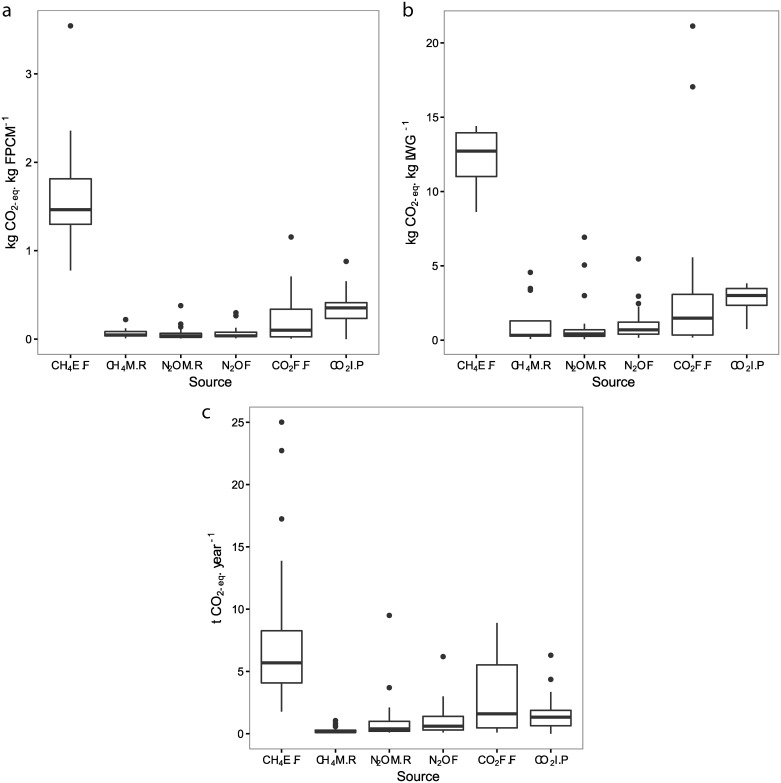
Mean GHG emissions (n = 30) from different sources in relation to a. milk produced; b. liveweight gain; or c. per year.The emission sources are methane from enteric fermentation (CH4E.F), methane from manure residues (CH4M.R), nitrous oxide from manure residues (N2OM.R), nitrous oxide from fertilizer use (N2OF), carbon dioxide from fossil fuel (CO2F.F) and carbon dioxide from producing inputs (CO2I.P). Emissions are expressed in a. kg CO2-eq. (kg FPCM†)-1
b. kg CO2-eq. (kg LWG)-1, live weight gained animal-1 day-1
c. tonnes CO2-eq. per farm year-1. Circles indicate outliers. †FPCM = raw milk (kg) * (0.337 + 0.116 * fat% + 0.06 * protein%).